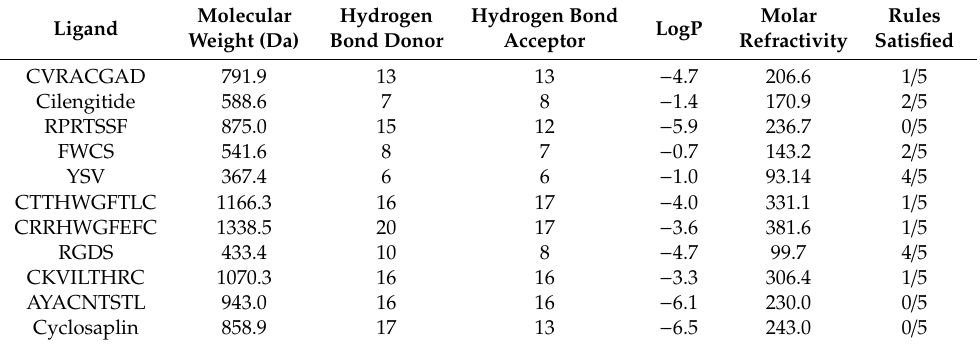
Table 3. Physiochemical parameters of ligand molecules screened for Lipinski’s